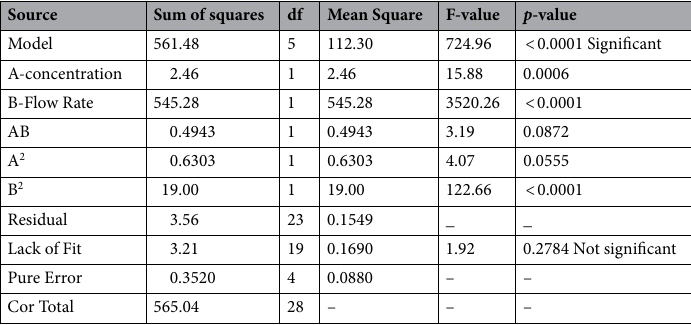
Table 7. Cooling range data of TiO 2 nanofluid from ANOVA.